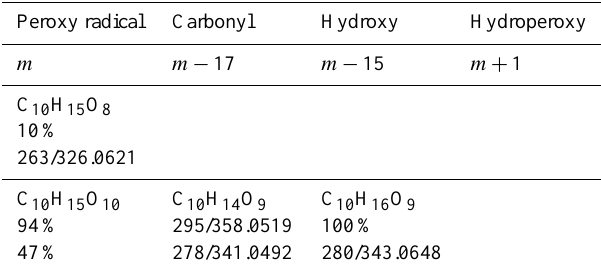
Table 13. HOM products observed during ozonolysis of (cid:49) -3- carene. The second header line shows at which molar masses the termination products are expected relative to the peroxy radical with molar mass m (unit masses). Filled cells indicate that these com- pounds were detected with given elemental composition and rel- ative intensity (second line in the same cell). Relative intensities were normalized to the largest HOM signal. The third line in the cell gives the molar mass [Da] in unit mass resolution and the pre- . cise m/z [Th] at which the molecule was detected as cluster with 3 15 NO − . 3 Peroxy radical Carbonyl Hydroxy Hydroperoxy